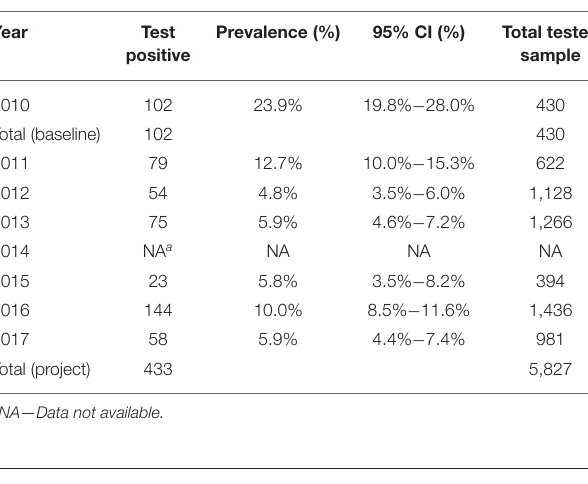
TABLE 4 | Prevalence of EZL in cart mules in Bahir Dar from baseline and annual prevalence surveys.